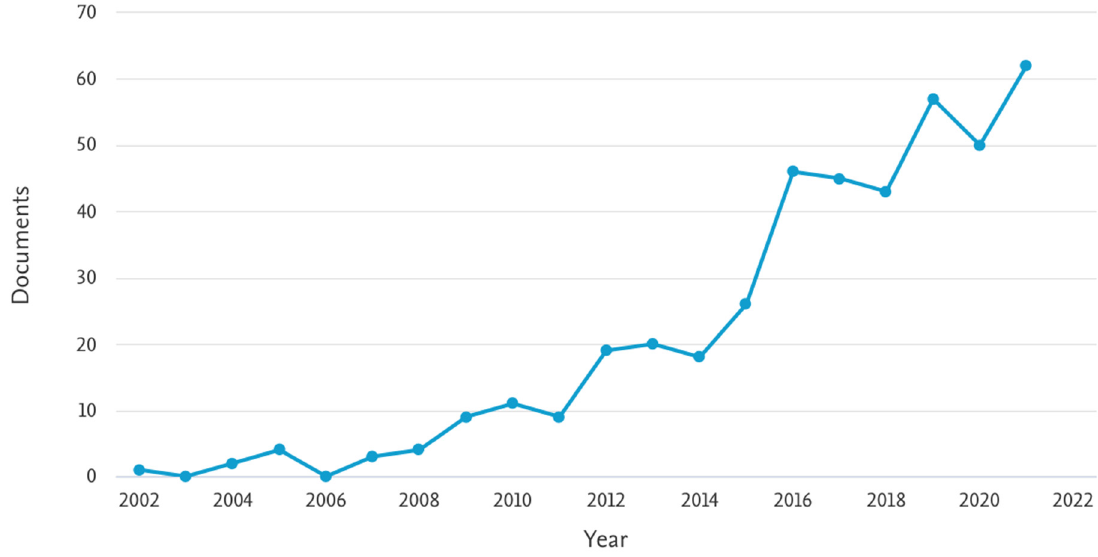
Figure 1. Search results (keywords “Fibroin” and “Bone” and “Regeneration”) indicating the number of published documents by year. Source: Scopus (https://www.scopus.com accessed on 15 June 2022).